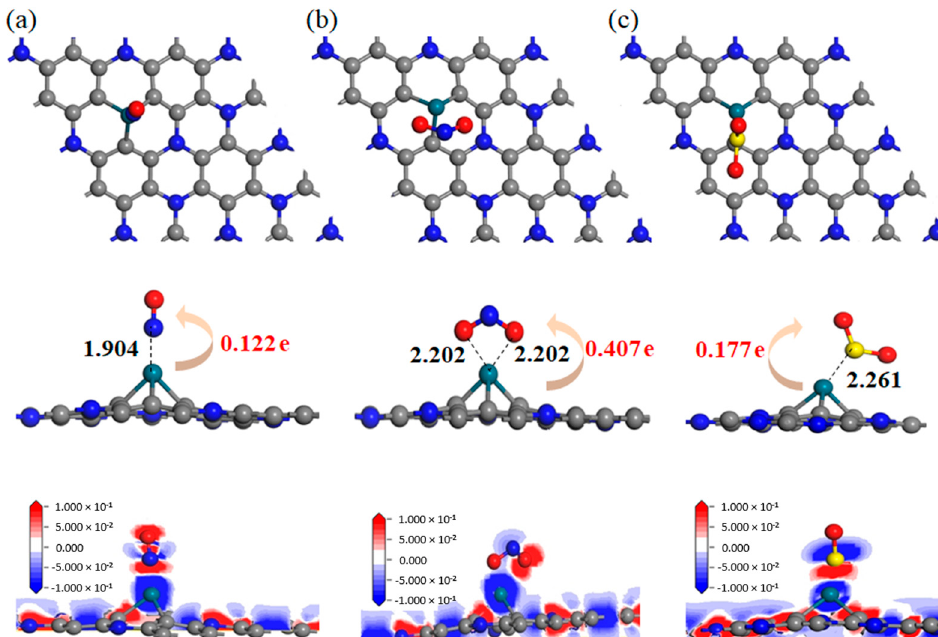
Figure 4. The steadiest adsorption configuration of gas on the Pd-C 3 N monolayer and the DCD of this configuration ( a ) NO; ( b ) NO 2 and ( c ) SO 2 adsorption systems. Table 3. The geometrical parameters of three gas adsorption systems.